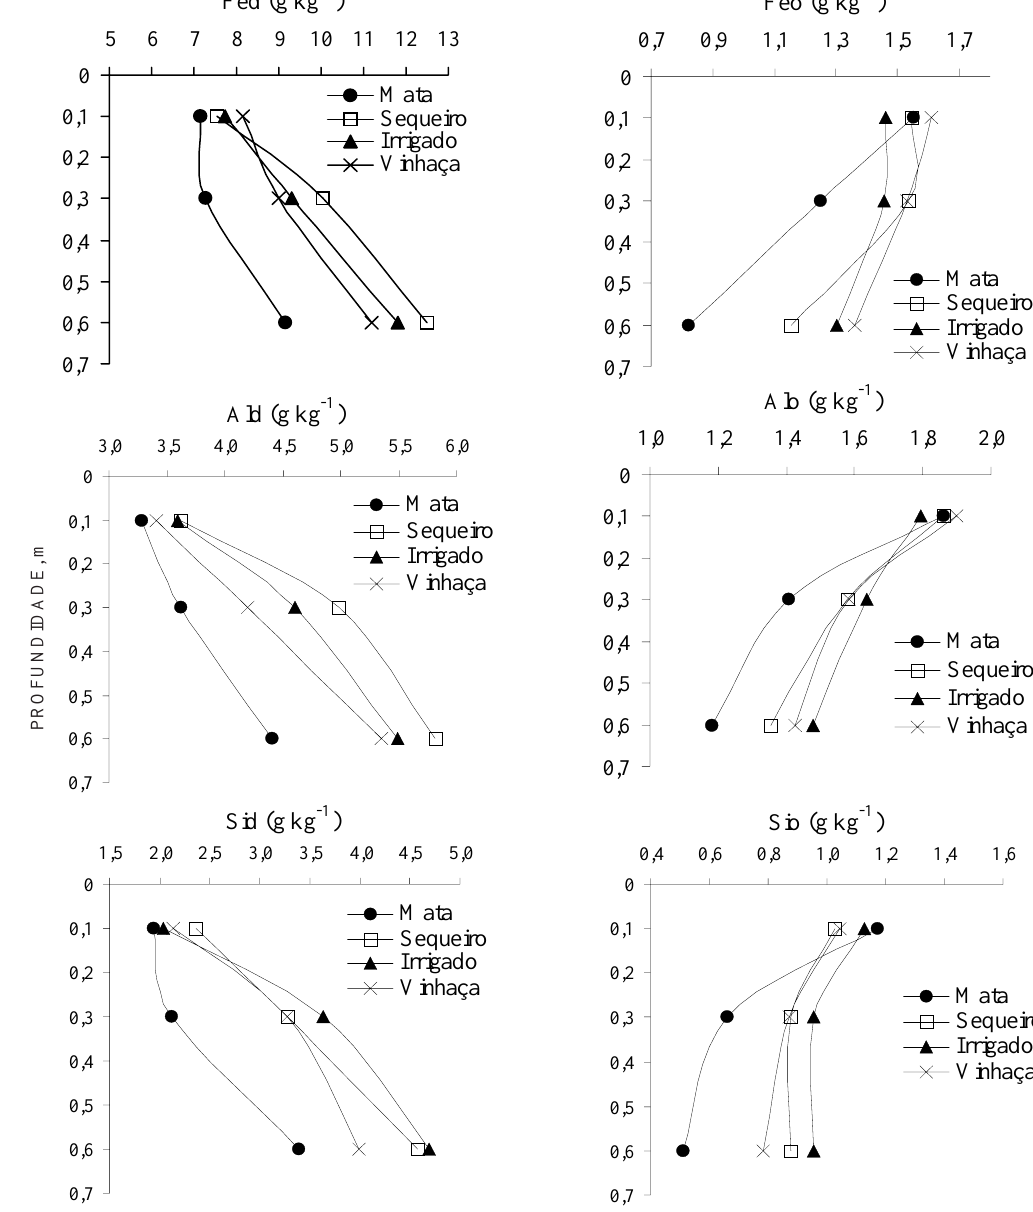
Figura 1. Distribuição de Fe, Al e Si ditionito (Fed, Ald e Sid) e Fe, Al e Si oxalato (Feo, Alo e Sio) em profundidade nos sistemas de uso e manejo